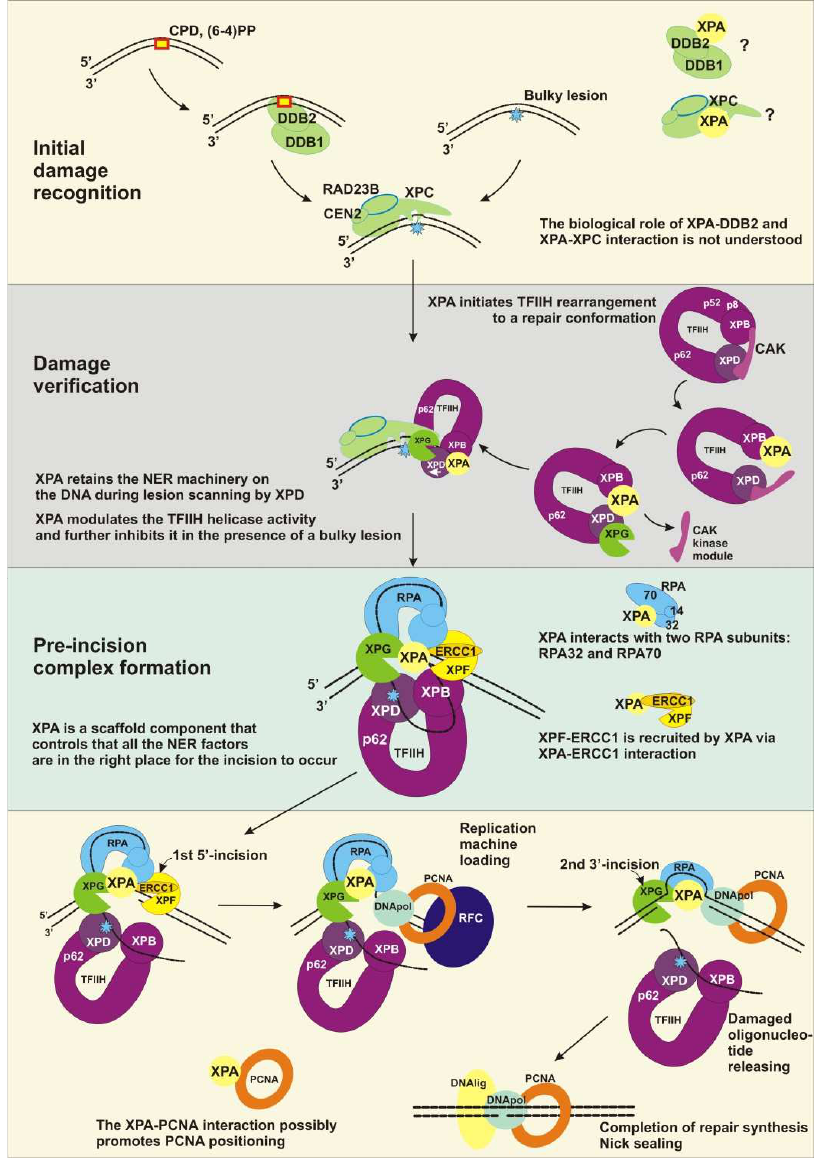
Figure 3. XPA organizes GG-NER machinery functioning. (Initial damage recognition) XPA interacts physically with DDB2 and XPC, but the biological role of these interactions is not understood.